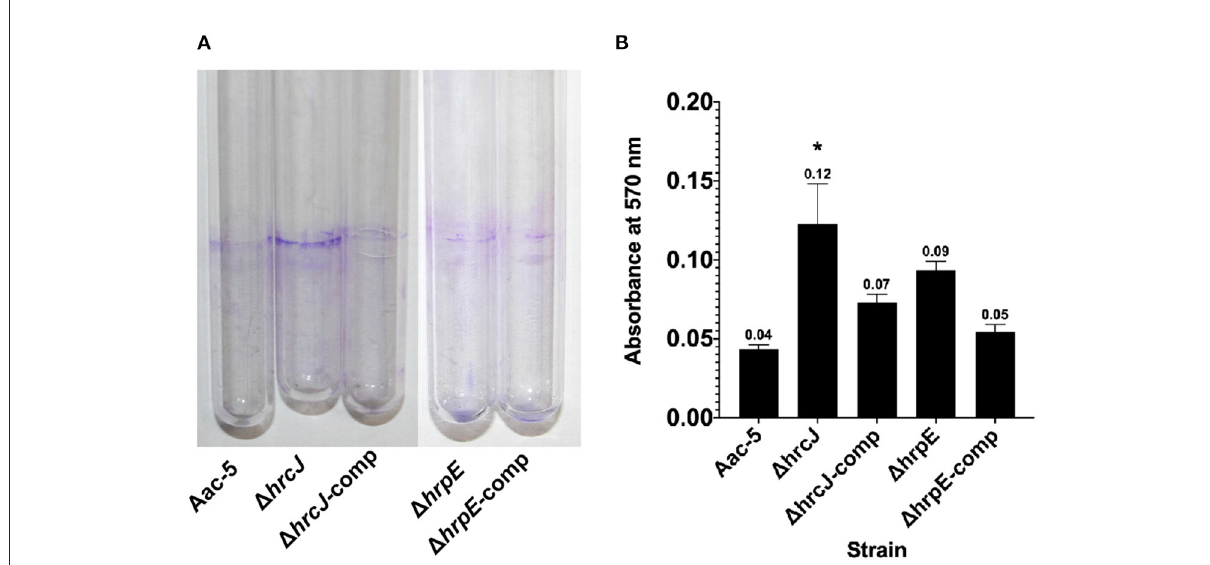
FIGURE5 Effect of hrcJ and hrpE on biofilm formation of A. citrulli strains. (A) After 7 days incubation, the A. citrulli strains formed biofim on the inner wall of the cultural tubes, and then were visualized by staining with crystal violet. (B) Biofilm formation was quantified by measuring absorbance at 570nm of the crystal violet stained biofilm dissolved with ethanol. The OD 570 for each strain is the average of three experiments. The bars represent standard errors of the means. Asterisk indicates significant difference at P < 0.05 by the Student’s t -test.